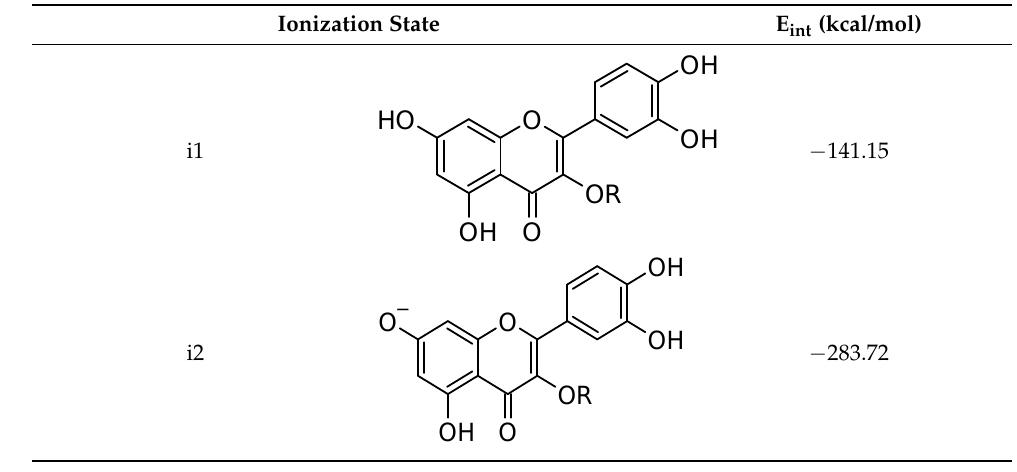
Table 1. Average interaction energies of ionization states i1-4 of rutin with the aqueous environment (0.15M NaCl). R represents the rutin glycon.